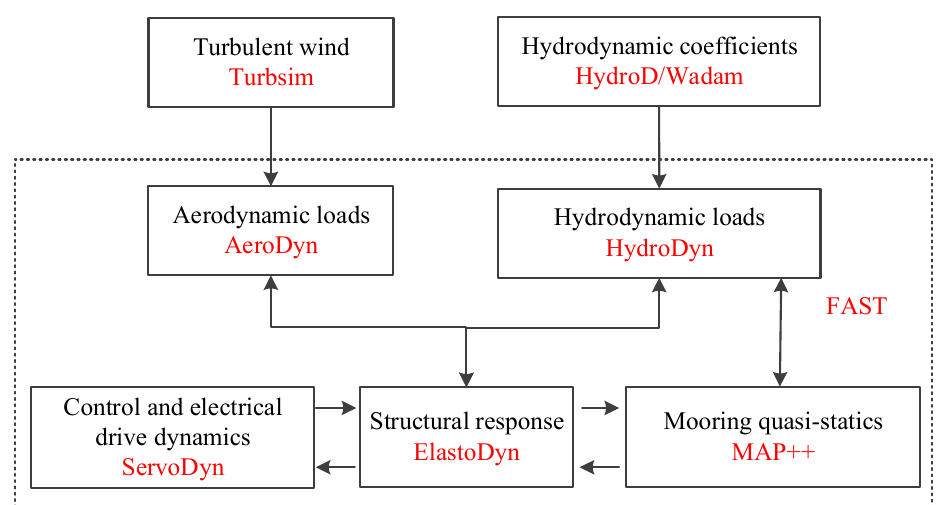
Figure 3. An overview of codes used in the fully coupled analysis [3].